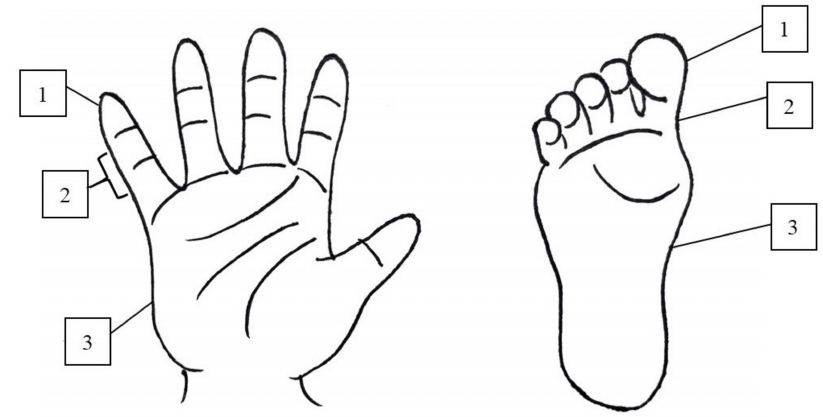
Figure 1. The illustration to identify the grade of